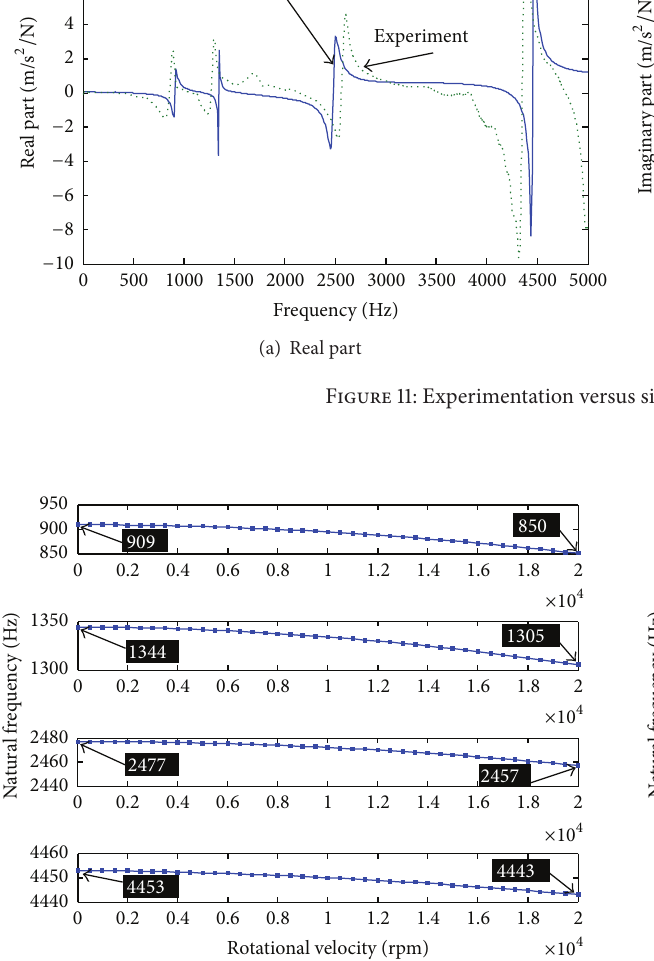
Figure 12: Centrifugal force effect of shaft only.